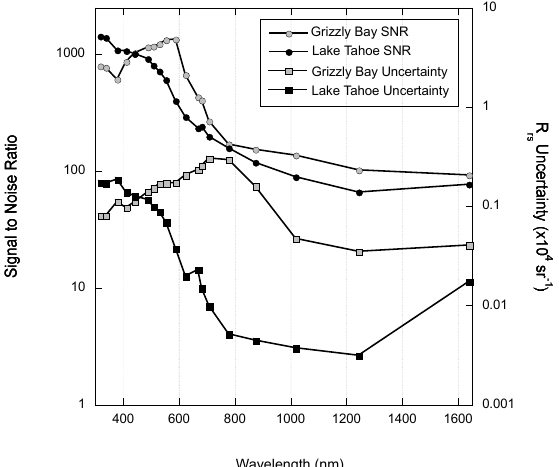
Figure 5. Signal-to-noise ratio (circles) and R rs uncertainty (squares) for C-AERO from Grizzly Bay (grey) and Lake Tahoe (black).